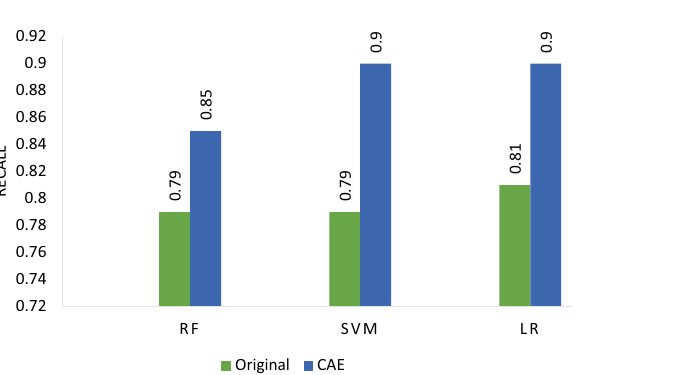
Figure 8. Comparison of original features vs. CAE reduced transformation on zero-day test